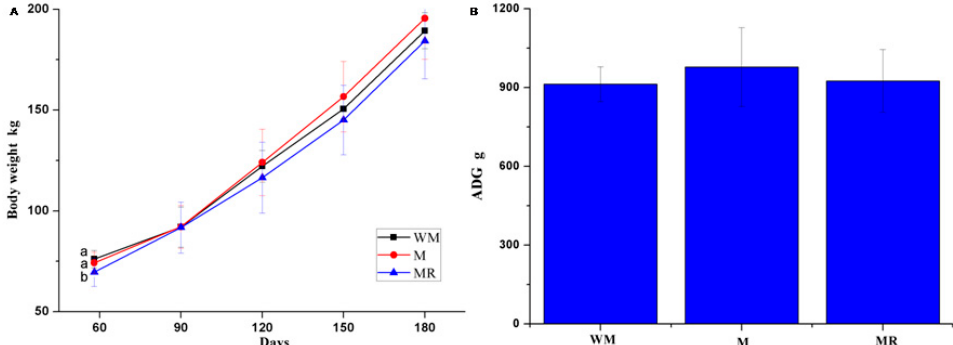
Table 6. Stomach development for two-month-old calves (male, n = 3 per each treatment). Items